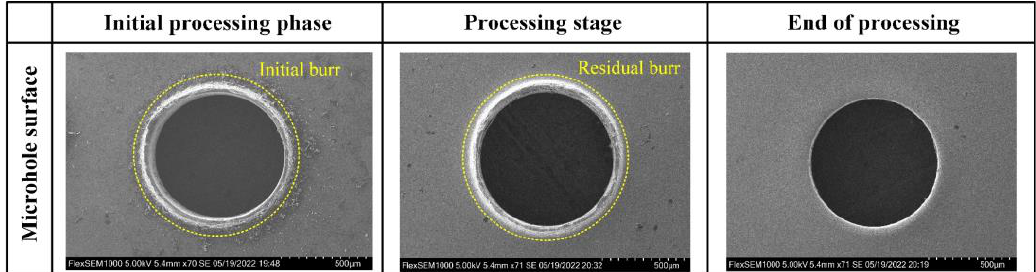
Figure 16. Orifice morphology before and after deburring.